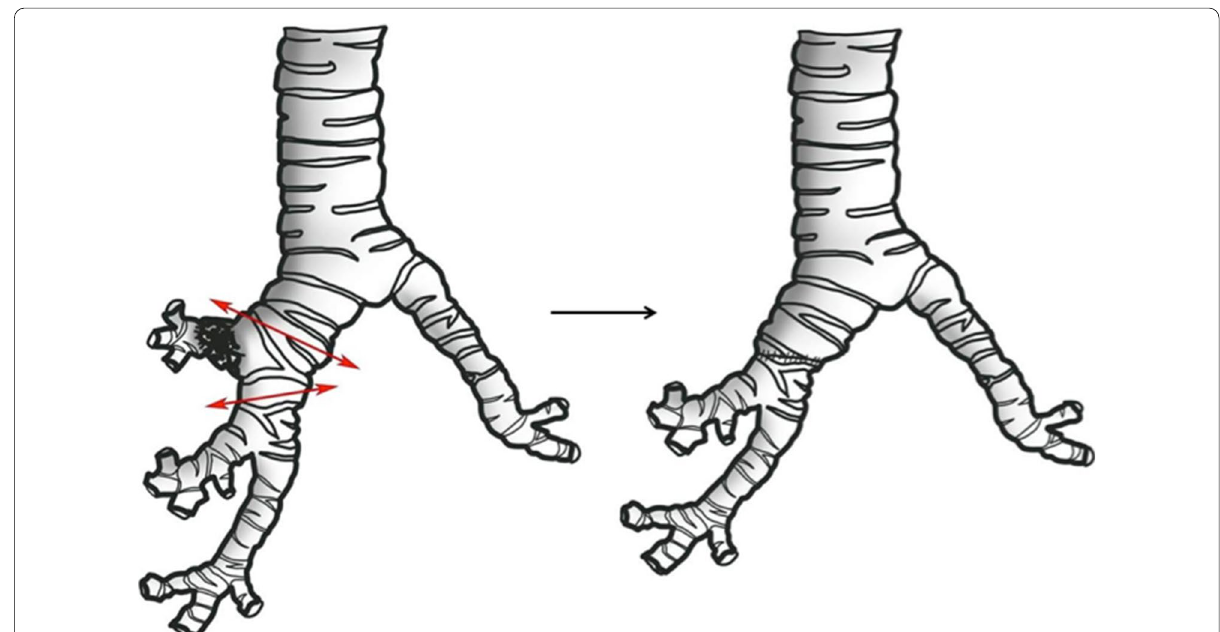
Fig. 7 Schematic figure of sleeve lobectomy. Left: tumour involving the proximal right upper lobe bronchus is resected along with a segment of the intermediate bronchus with negative margins along with a segment of the intermediate bronchus. Right: termino‑terminal anastomosis is